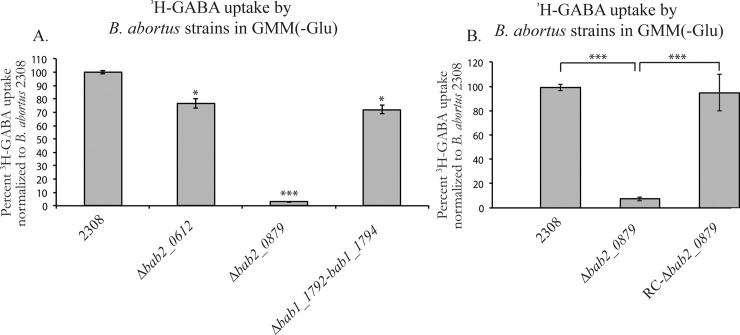
Transport of 3H-GABA transport in B. abortus 2308 by AbcR regulated systems.A. 3H-GABA uptake by B. abortus 2308, Δbab2_0612, Δbab2_0879, Δbab1_1792Δbab1_1794, and Δbab2_0879 in assessed in minimal medium, GMM(-Glu). Data is normalized to 2308 at 100%. Asterisks denote a statistically significant difference (* P<0.05, *** P<0.0005; Student’s t test) in uptake between B. abortus 2308 and deletion strains. B. 3H-GABA uptake by B. abortus 2308, Δbab2_0879, and Δbab2_0879-RCbab2_0879 in minimal medium, GMM(-Glu). Data is normalized to 2308 at 100%. Asterisks denote a statistically significant difference (*** P<0.0005; Student’s t test) in uptake between strains.